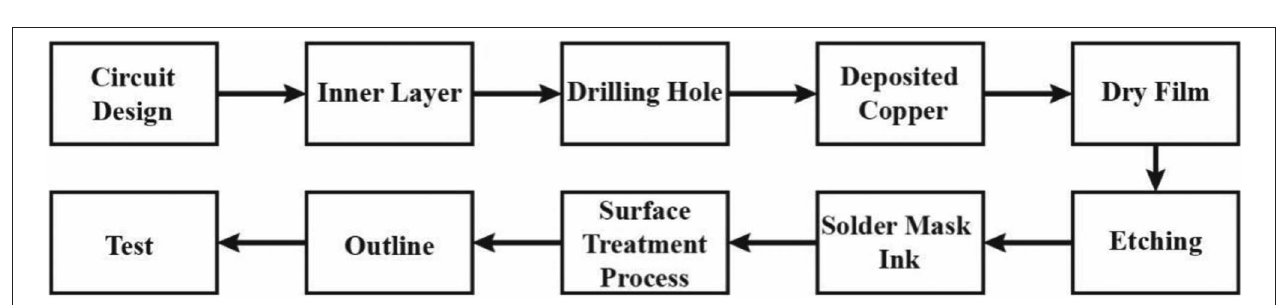
FIGURE 5 | The steps for manufacturing PCBs. There are main ten steps for manufacturing PCBs. Firstly, a correct circuit diagram is generated a Gerber film. According to the diagram, the inner layers are bonded together, the electrical connection is conducted by drilling, the copper is deposited in the hole as the base of electroplated copper, a layer of dry film is pasted on the layout, and the desired pattern can be obtained by etching, and then, the electrode is surface-treated for outline and